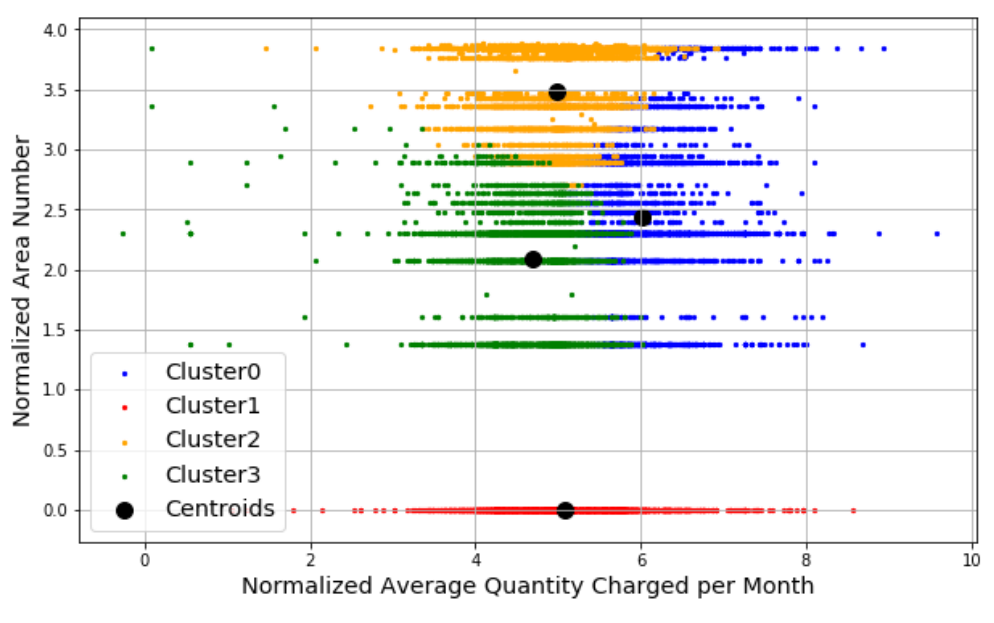
Figure 18. K-means clustering